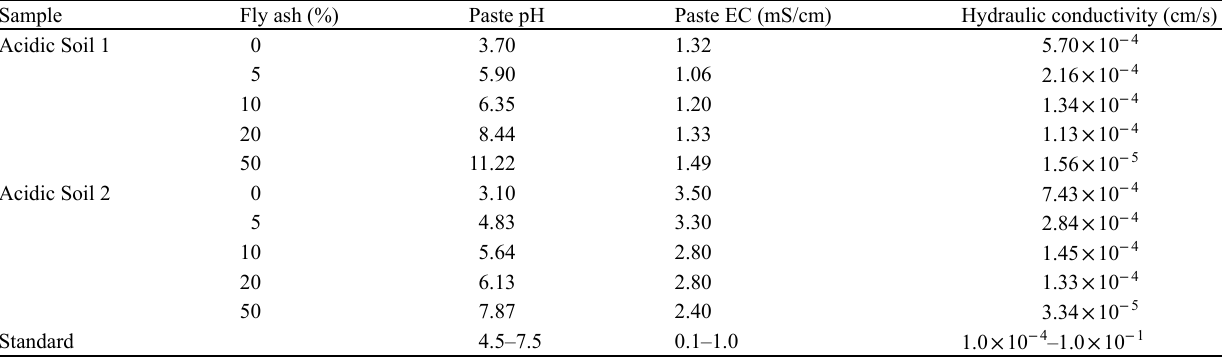
Table 3 Paste pH, Paste EC, hydraulic conductivity of mixed soils Sample Fly ash (%) Paste pH Paste EC (mS/cm) Hydraulic conductivity (cm/s) Acidic Soil 1